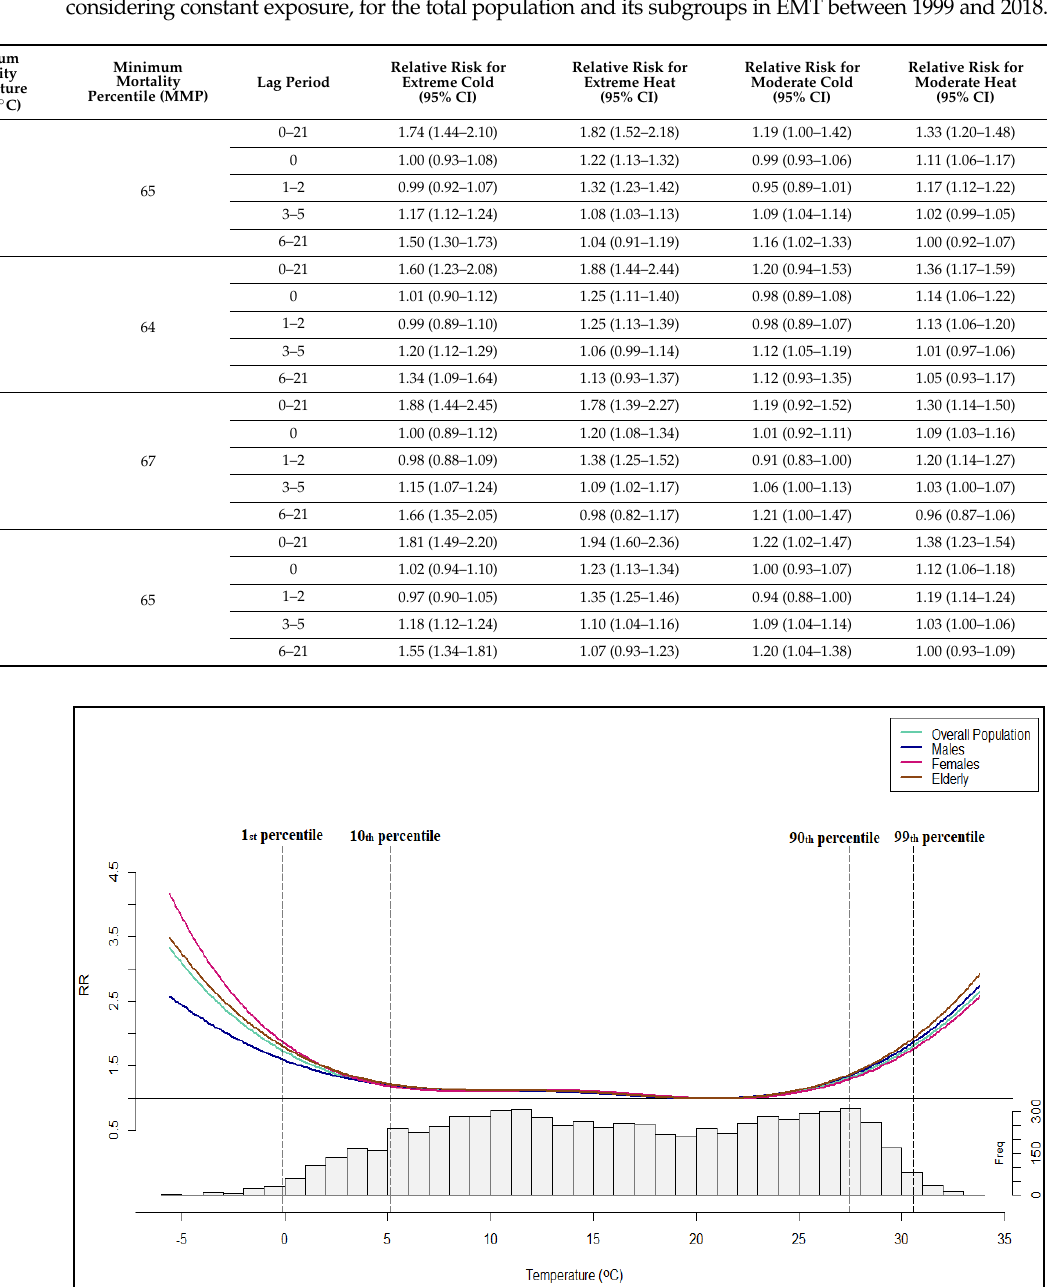
Figure 5. The cumulative exposure-response curve of mean daily temperature for the total population and its subgroups in EMT for a lag period of 21 days. all relative risks of mortality were estimated for exposure to extreme temperatures. Re- garding the two genders, exposure to extreme heat was more dangerous for males (lag 0– 21: 1.88, CI: 1.44–2.44), whereas females were found to be more sensitive to extreme cold, with a relative risk of cardiorespiratory mortality equal to 1.88 (CI: 1.44–2.45) on lag 0–21